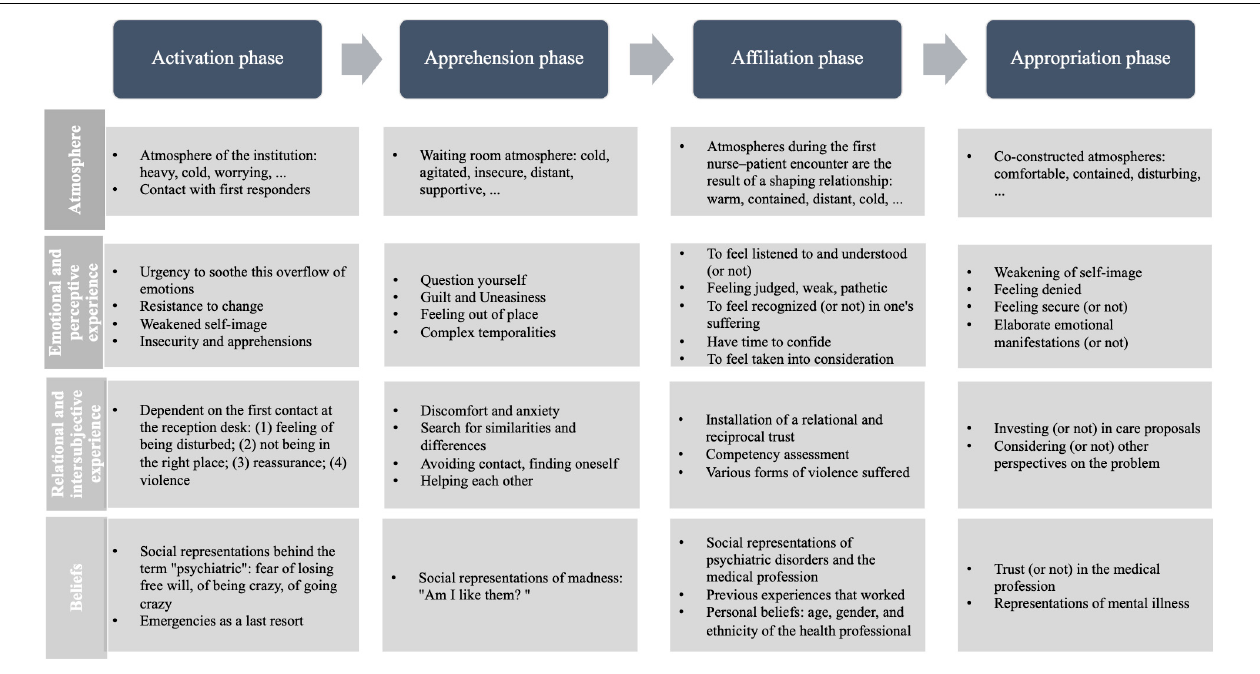
FIGURE 3 | Modeling the phenomenon of "being